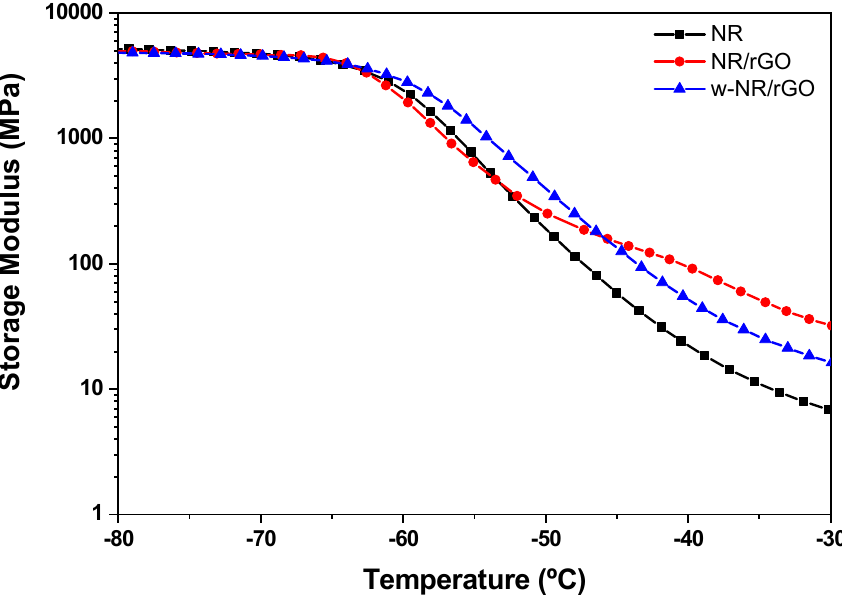
Figure 5. Storage modulus of NR, NR/rGO 4.0 wt.% and w-NR/rGO 4.0 wt.%.